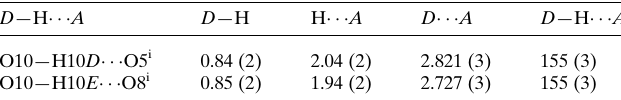
Table 3 Hydrogen-bond geometry (A˚ , (cid:5) ) for III .